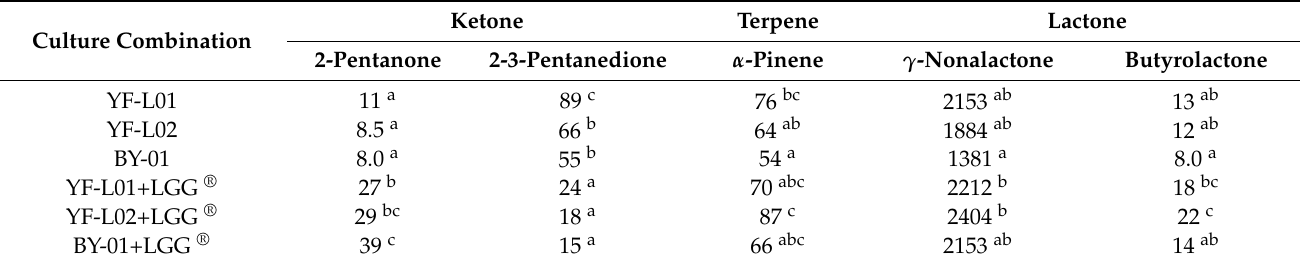
Table A5. Fermented coconut